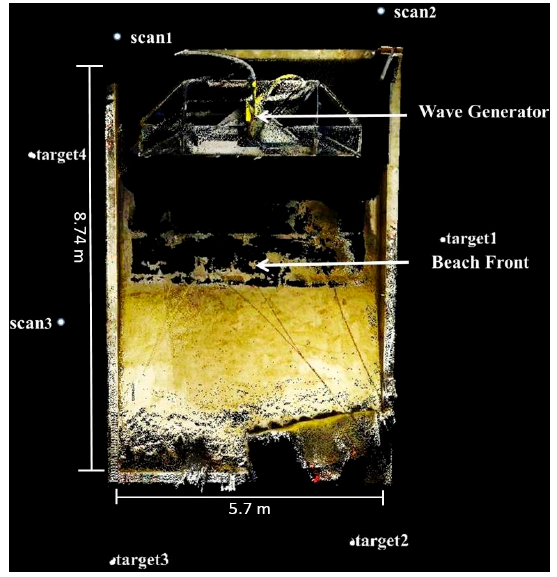
Figure 1. Bird’s-eye view of the initial experimental setup from the 3D data obtained by terrestrial LiDAR.